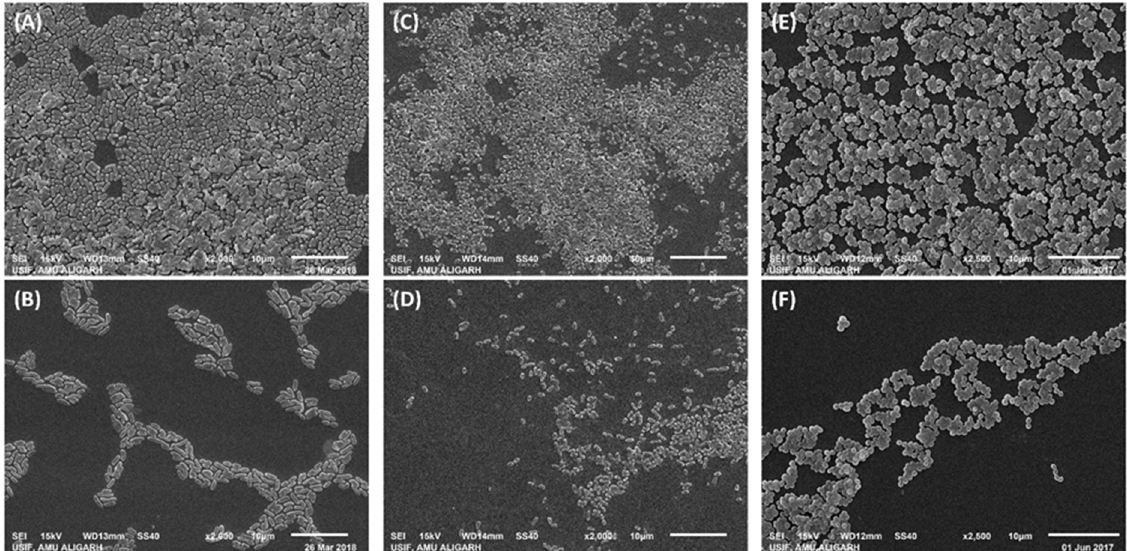
Figure 6. Scanning electron microscopic images of the E. coli , P. aeruginosa , and S. aureus biofilms in the absence and presence of ZnO-NPs. ( A ) Untreated control E. coli ; ( B ) E. coli treated with ½ × MIC of ZnO-NPs; ( C ) untreated control P. aeruginosa ; ( D ) P. aeruginosa treated with ½ × MIC of ZnO-NPs; ( E ) untreated control S. aureus ; ( F ) S. aureus treated with ½ × MIC of ZnO-NPs.